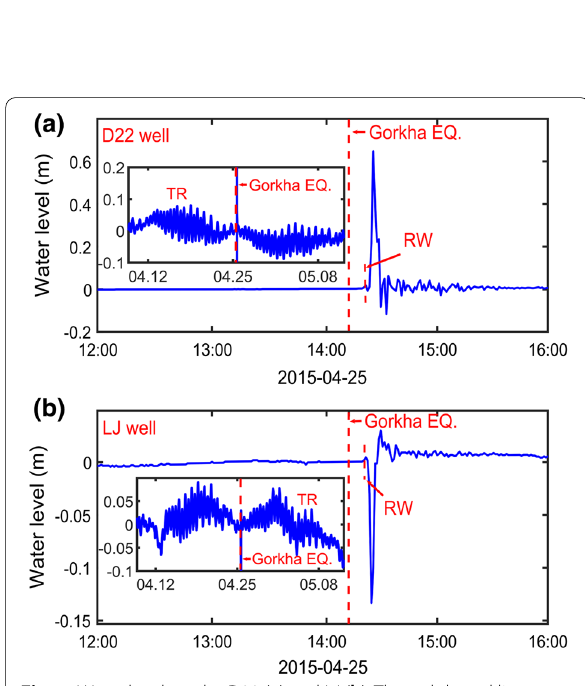
Fig. 4 Water levels at the D22 ( a ) and LJ ( b ). The red dotted lines represent the earthquake origin time. RW is the arrival time of Rayleigh wave. TR is the tidal response of water